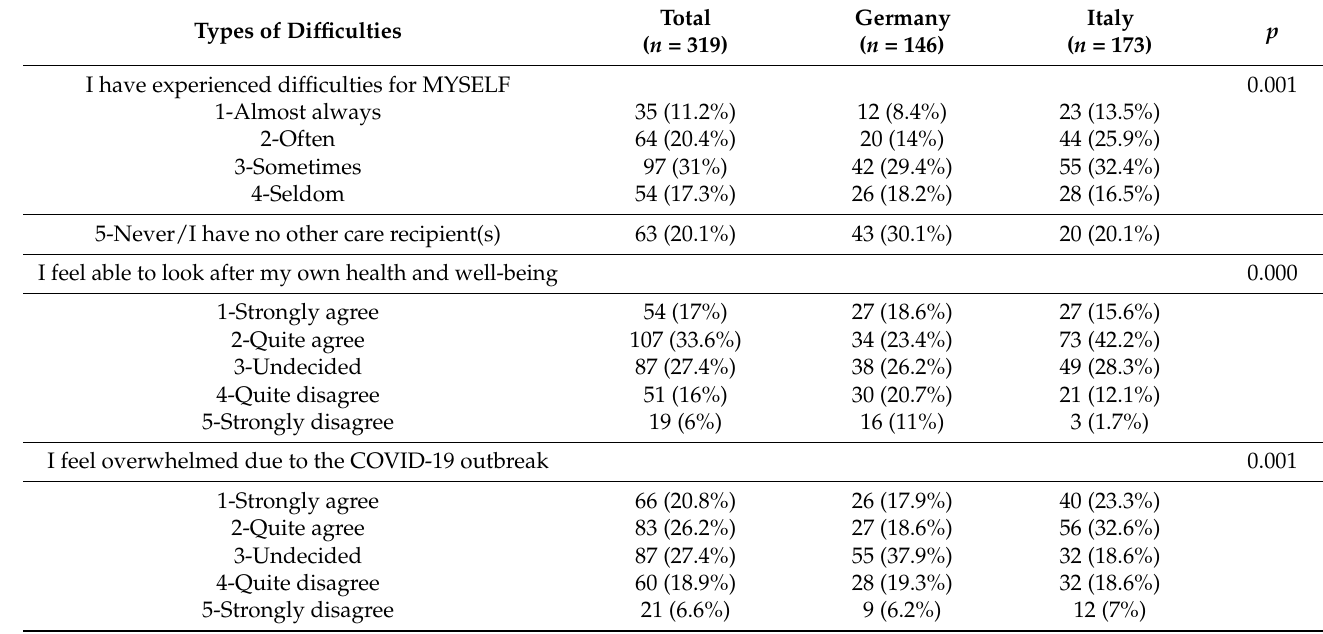
Table 4. Difficulties faced by informal caregivers during the COVID-19